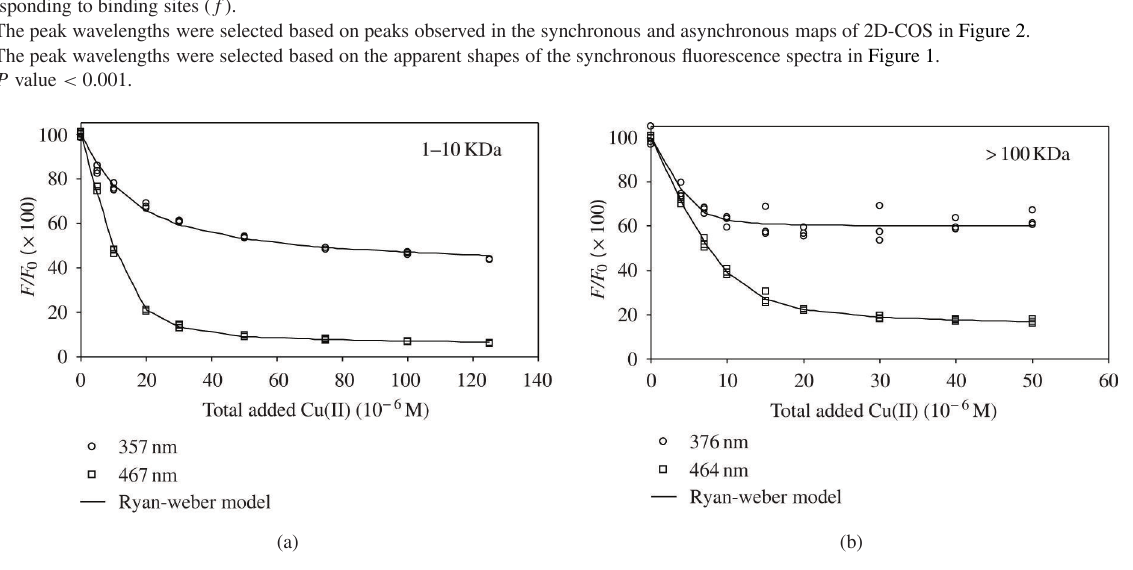
FIGURE 3: Representative fluorescence quenching curves for the (a) 1–10 K fraction and (b) the > 100 K fraction of the soil HA. The lines represent model-predicted